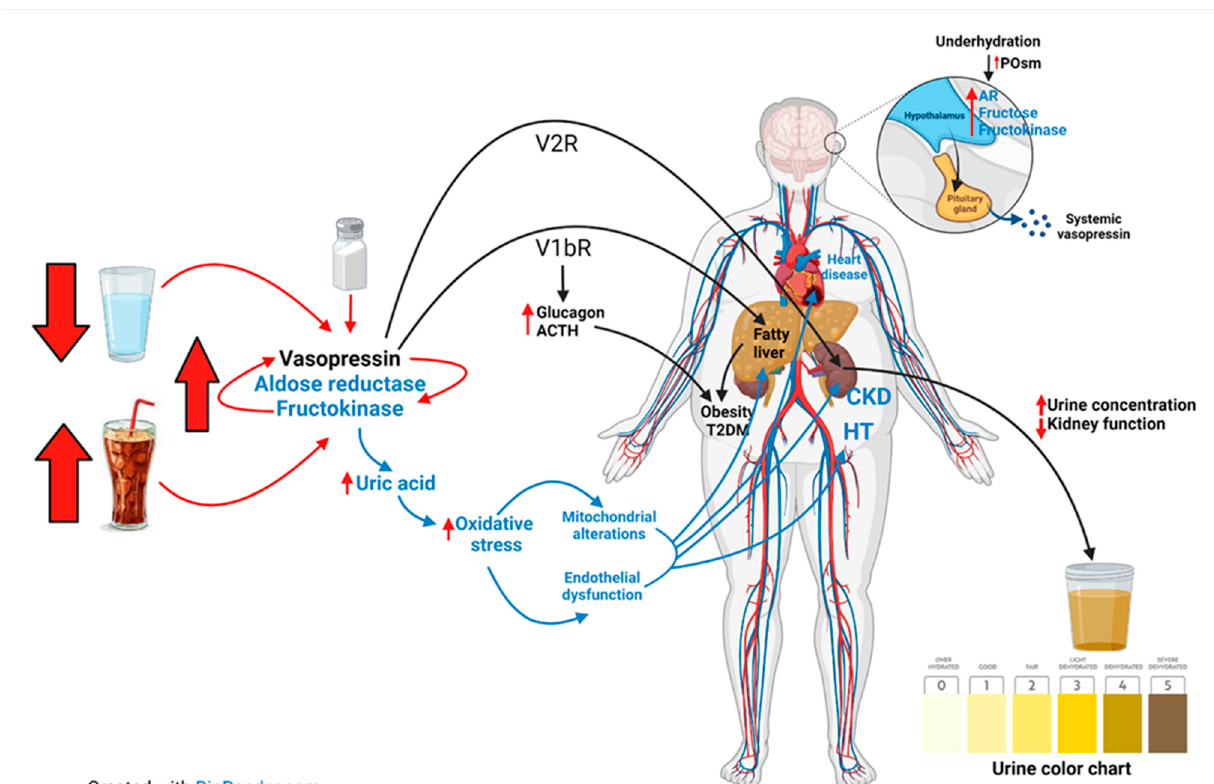
Figure 1. Low water intake coupled with sugar-sweetened beverage (SSB) intake activate both vasopressin and the aldose reductase-fructokinase pathways, which also can synergize with each other, aggravating target organ damage. In the brain, milder increases in systemic osmolality due to dehydration induce the expression of the aldose reductase pathway in the supraoptic nuclei of the hypothalamus, followed by the production of fructose. In turn, the fructose is metabolized locally by fructokinase, driving the synthesis of vasopressin. The increased vasopressin activity stimulates V2R in the kidney, inducing urine concentration and chronically renal alterations. Stimulation of the V1b receptor occurs in the pancreatic islets as well as in the liver and the anterior pituitary, thereby stimulating the secretion of glucagon and the adrenocorticotropic hormone. V1bR stimulation also mediates fat production and other features of metabolic syndrome, such as fatty liver, obesity, and eventually, type 2 diabetes. Aldose reductase-fructokinase pathway activation induces an increase in uric acid synthesis which induces intracellular oxidative stress, mitochondrial alterations, and endothelial dysfunction. This eventually results in target organ damage, the organs that are more affected being the liver (fatty liver), heart (heart failure), kidney (chronic kidney disease) and the vessels (hypertension). High salt intake may lead to an increase in serum osmolality, thereby inducing chronic underhydration, activating both the polyol-fructose and vasopressin pathways. (Abbreviations: ACTH, adrenocorticotropic hormone; AR, aldose reductase; CKD, chronic kidney disease; HT, hypertension; POsm, Plasma osmolality; T2DM, type 2 diabetes mellitus) .